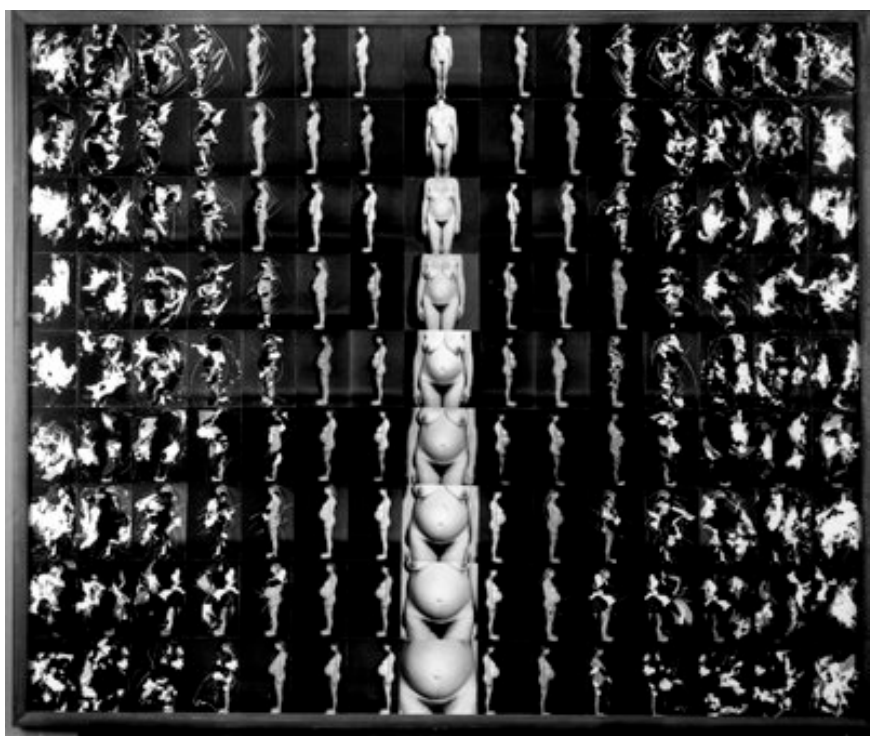
Figure 7. Annegret Soltau, Schwanger (Pregnant), 1977–82. Copyright: Annegret Soltau, VG Bild-Kunst, Bonn 2019.